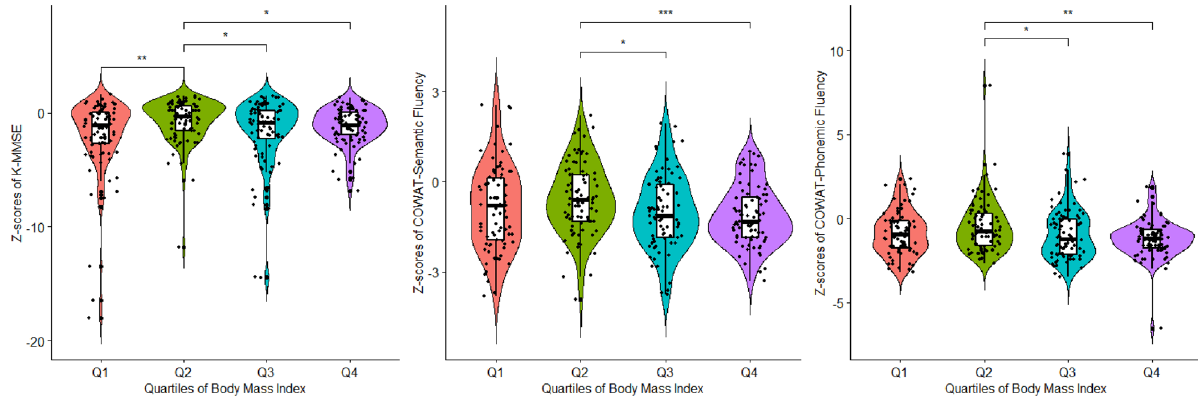
Figure 1. Violin plots indicating the association between the quartiles of BMI and z-scores of both K-MMSE and frontal cognitive domain in patients with ischemic stroke. The z-scores of K-MMSE, COWAT-semantic, and COWAT-phonemic were significantly different between the groups after adjusting for initial stroke severity. ( p values, 0.014, 0.034 and 0.023 respectively; ANCOVA) *Abbreviations: BMI ,body mass index; K-MMSE Korean version of mini-mental status examination; COWAT controlled oral word association test, ANCOVA analysis of covariance.